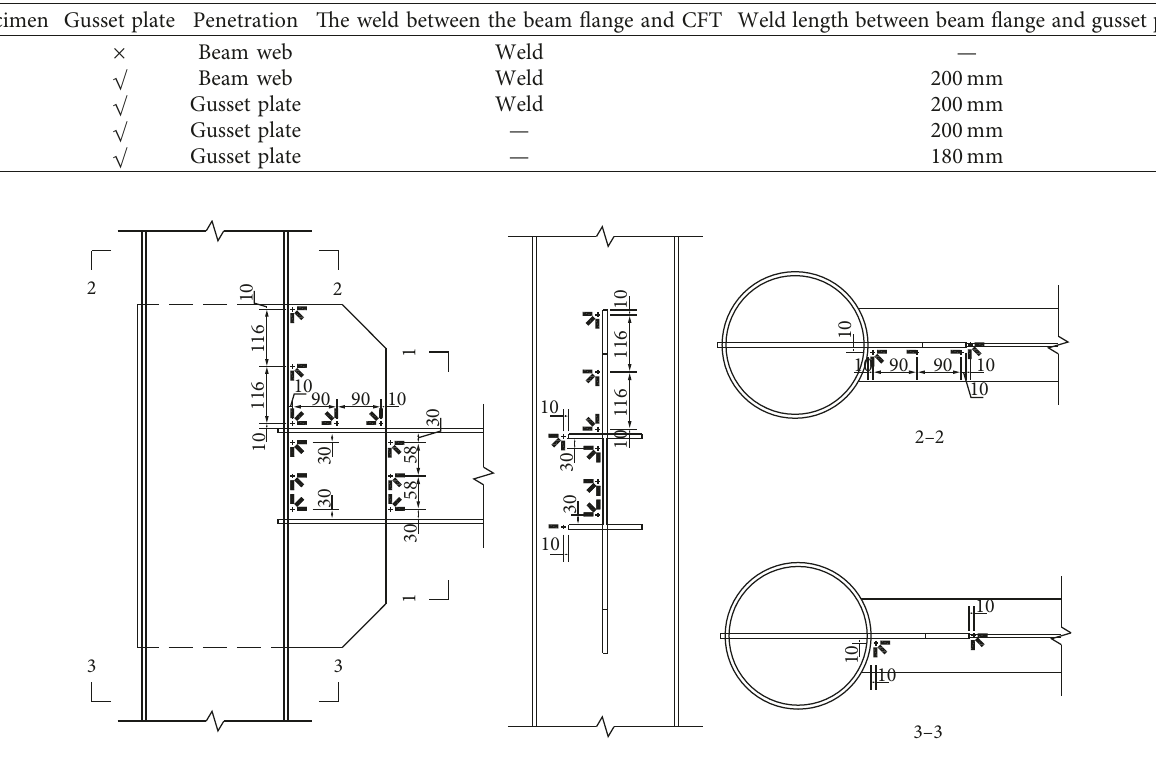
Figure 3: Layout of strain gauges